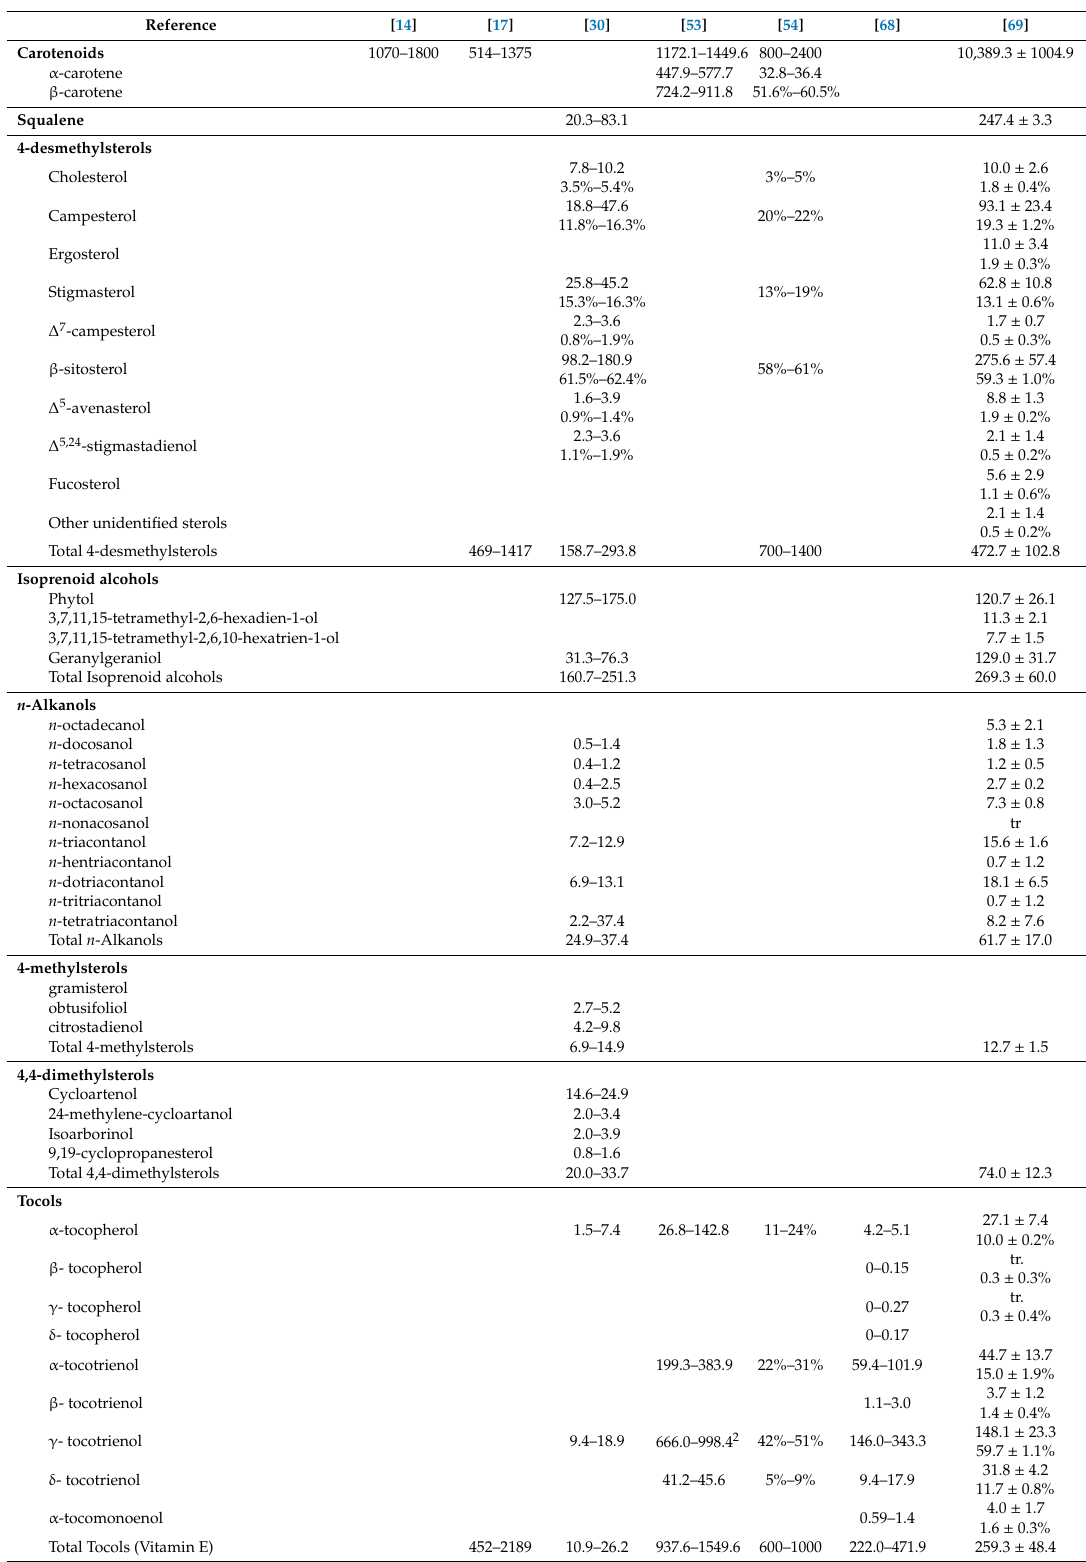
Table 4. Unsaponifiable matter constituents (mg / Kg oil unless % is indicated) of interspecific hybrid palm oil. Percentages refer to within class of unsaponifiable